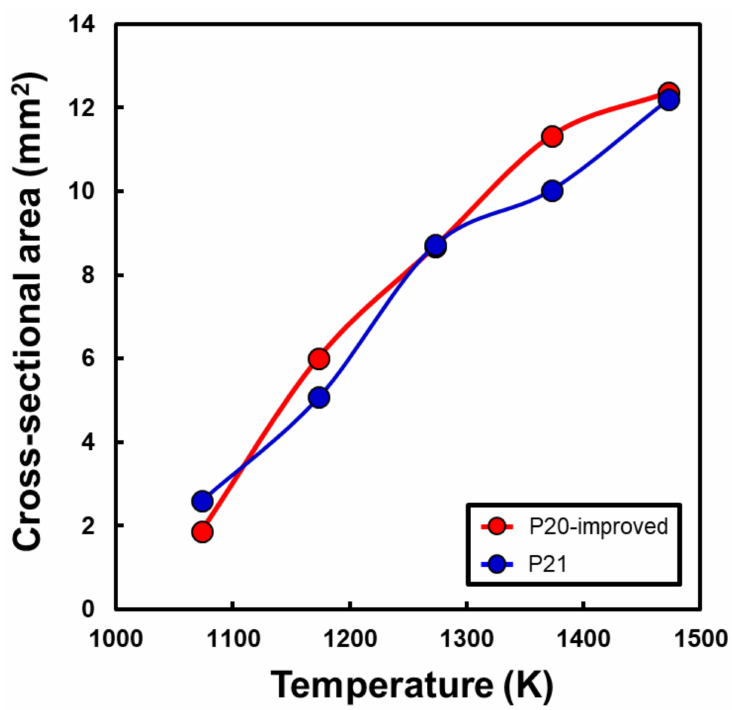
Figure 7. Relationship between the laser-assisted heat treatment temperature and cross-sectional area of the heat-treated zone for P20-improved and P21